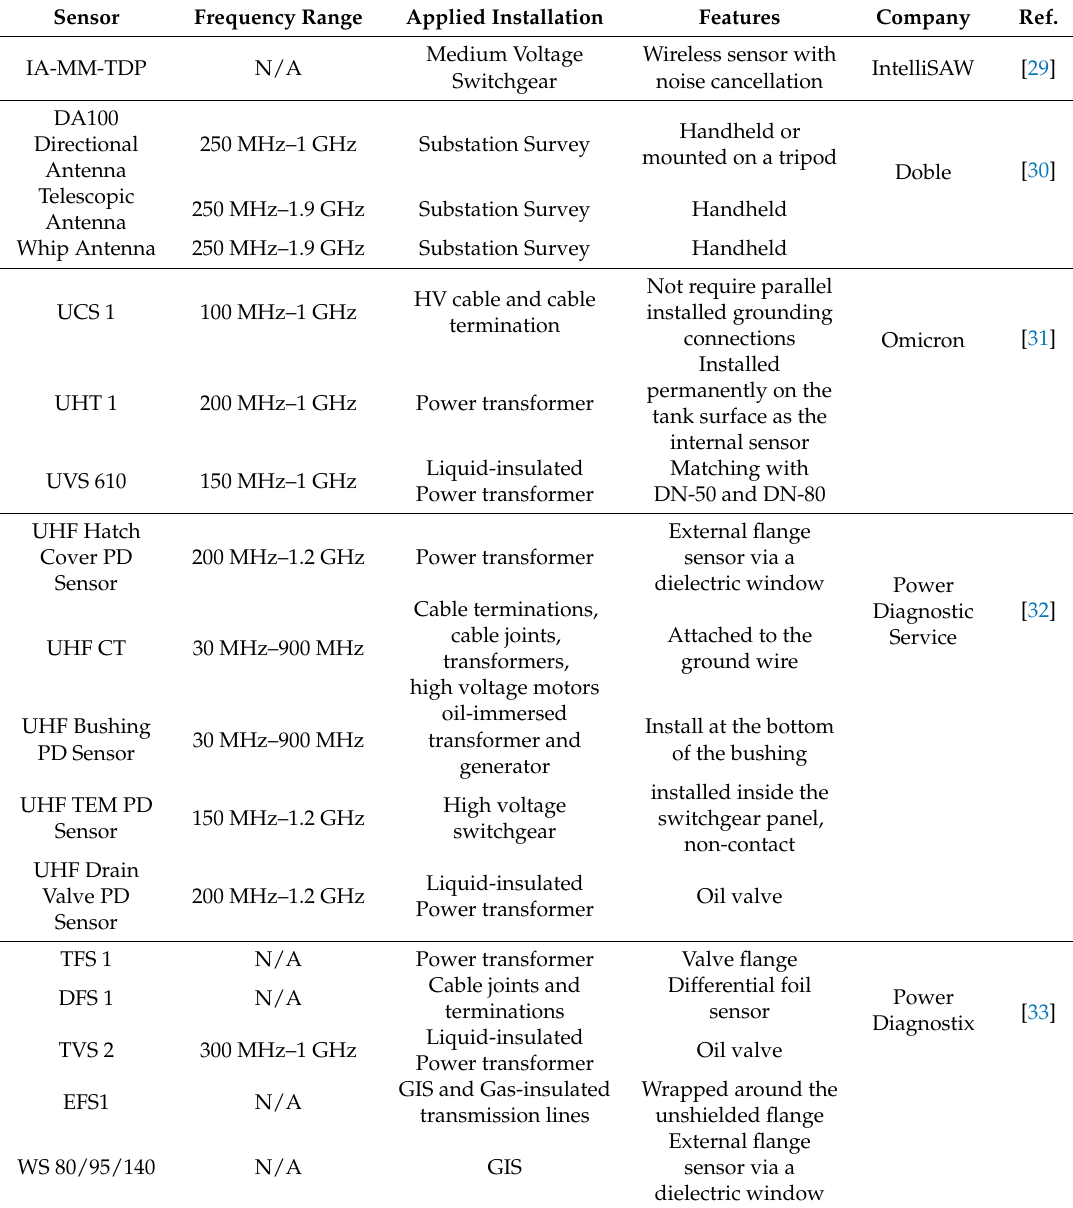
Table 2. Comparison of commercial UHF sensors for PD